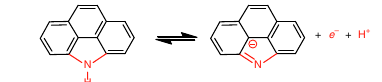
content-dependent pseudocapacitance .